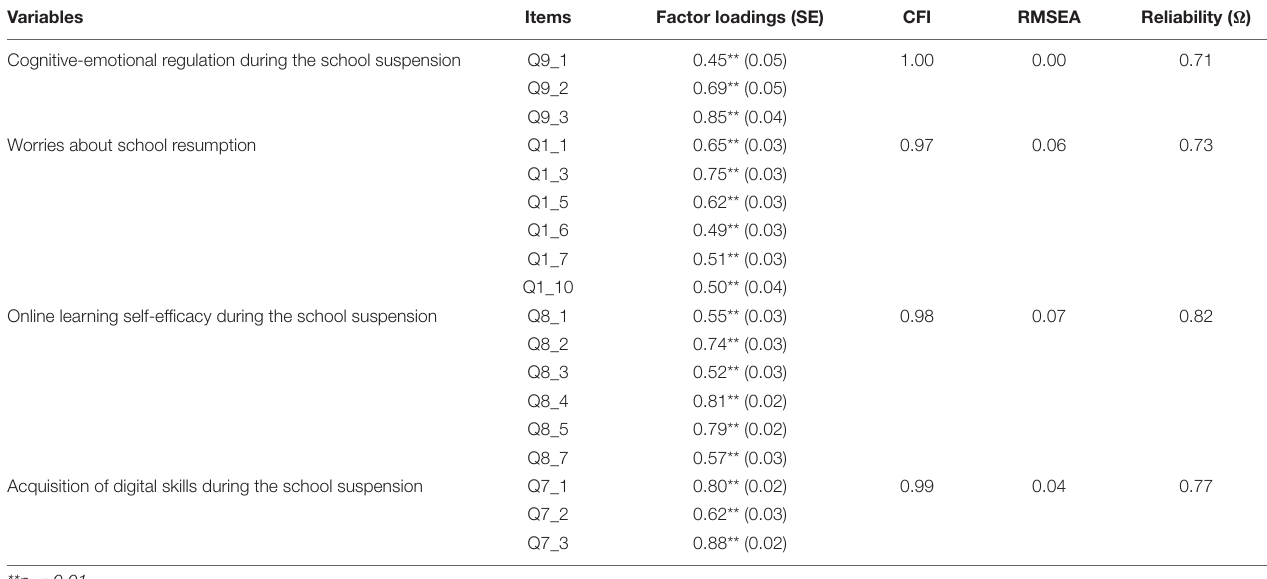
TABLE 4 | CFA for student outcome variables (secondary schools).